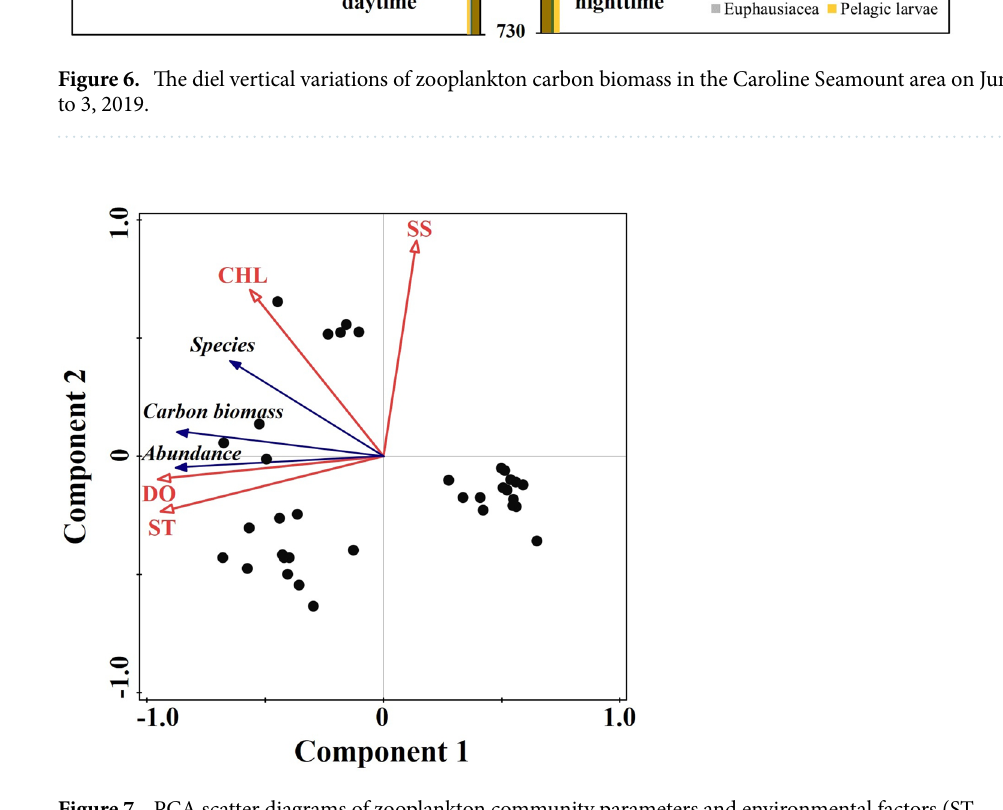
Figure 7. PCA scatter diagrams of zooplankton community parameters and environmental factors (ST, seawater temperature; SS, seawater salinity; CHL, chlorophyll fluorescence; DO, dissolved oxygen) of different sampling layers in the Caroline Seamount area on June 2 to 3,